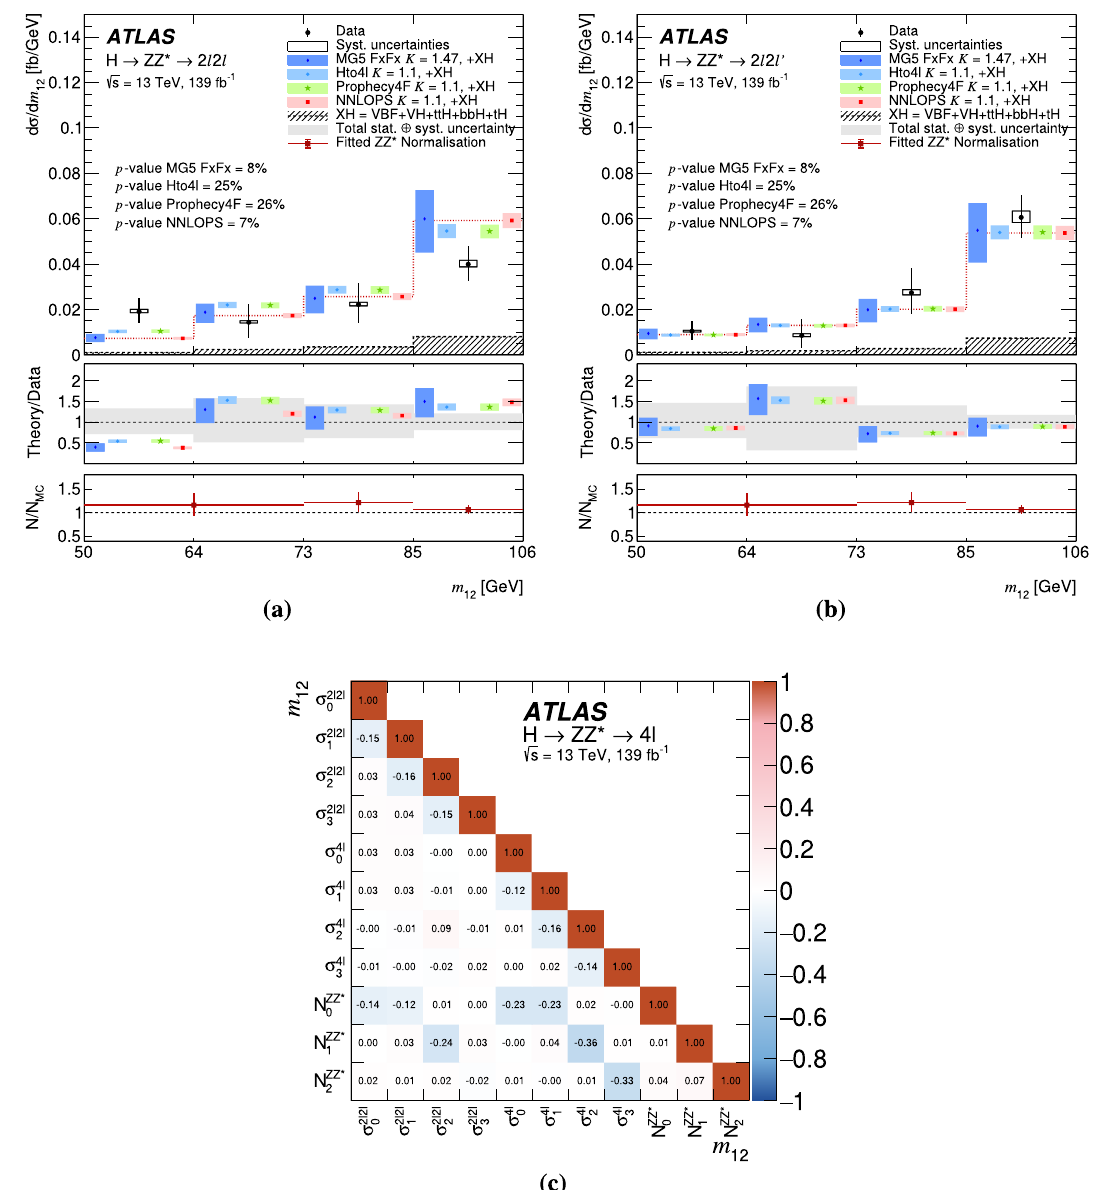
Fig. 43 Differential fiducial cross sections for the invariant mass m 12 of the leading Z boson in a the 4 μ and 4 e decay channels and b the 2 e 2 μ and 2 μ 2 e decay channels. The corresponding correlation matrix is shown in